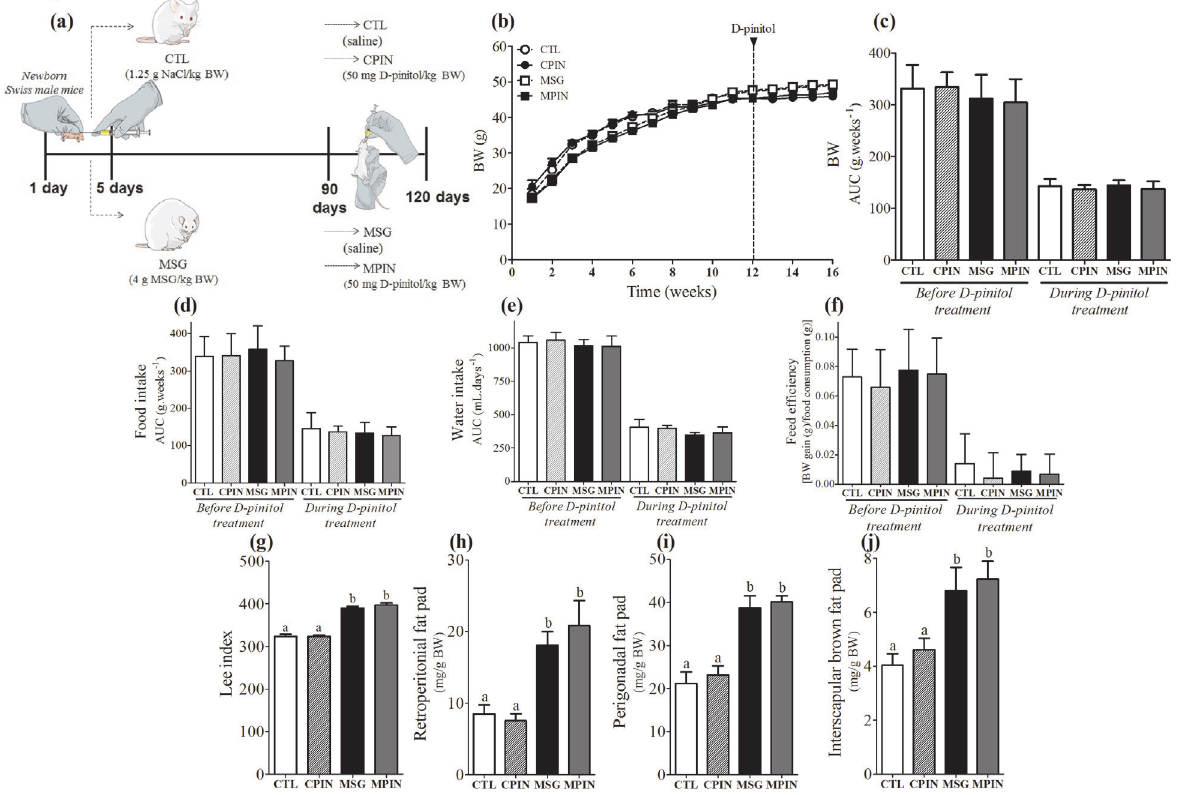
Figure 1. D-pinitol treatment did not change body weight or abdominal adiposity in MSG-obese mice. (a) Schematic representation of the experimental mice groups. From 90 to 120 days of age, CTL and MSG mice received a daily saline solution without (vehicle; CTL and MSG groups) or with 50 mg D-pinitol/kg BW via gavage (CPIN and MPIN groups). (b) Body weight (BW) of CTL (n = 26), CPIN (n = 28), MSG (n = 25) and MPIN (n = 27) mice, weekly registered before and during D-pinitol or vehicle treatments. Means ± SEM of total of BW (c), food (d) and water intake (e), and feed efficiency (f), expressed by the area under curve (AUC), registered before and during D-pinitol or vehicle treatments. Obesity parameters at the end of D-pinitol or vehicle treatments, expressed by the means ± SEM of Lee index (g), retroperitoneal (h) and perigonadal white fat pad (i), and interscapular brown fat pad weights (j). Different letters over the bars represent significant differences (Kruskal-Wallis followed by Dunns post-test, P <